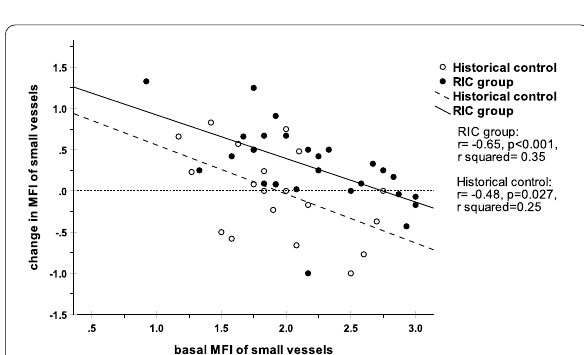
Fig. 4 Linear regression and Pearson correlation analysis of the basal microvascular flow index (MFI) of small vessels and the change in MFI of small vessels during the first RIC period in the historical control and RIC